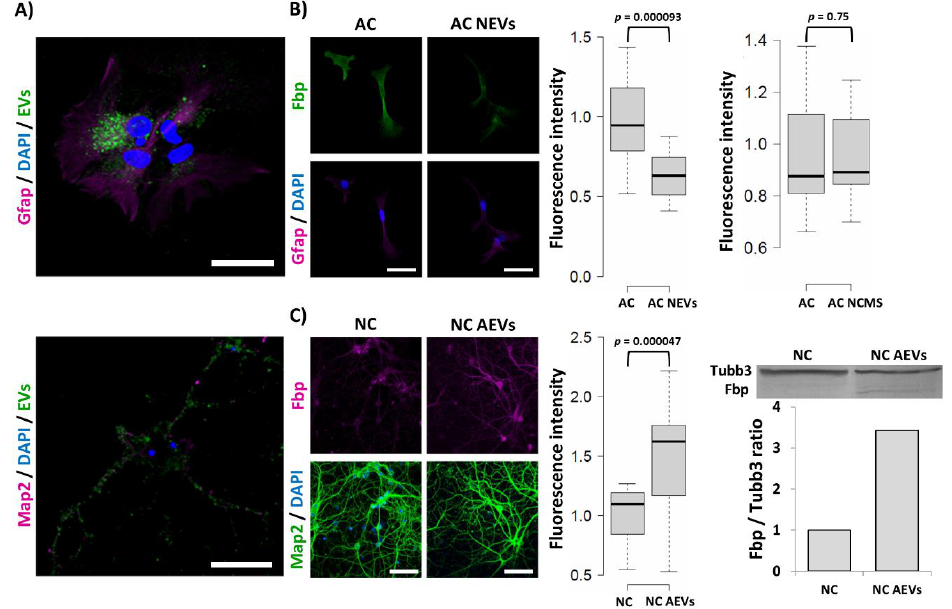
Figure 7. Extracellular vesicle-induced changes in the Fbp2 protein level in astrocytic and neuronal monocultures. ( A ) PKH67-stained (green) extracellular vesicles (EVs) absorbed by astrocytes (counterstained with Gfap) and neurons (counterstained with Map2). Bar = 40 µm. ( B ) Isolated neuronal EVs (NEVs) but not the EV-depleted supernatant (neuronal culture medium supernatant - NCMS) reduced the Fbp2 protein level in astrocytic cultures (ACs). Bar = 50 µm. ( C ) Isolated astrocytic EVs (AEVs) elevated the Fbp2 protein level in neuronal cultures (NCs), which was confirmed by Western blot. The WB membrane and densitometric analysis of Fbp-related band in reference to tubulin β3 (Tubb3) band is presented. Bar = 80 µm. Each fluorescence-based experiment was repeated at least in triplicate.